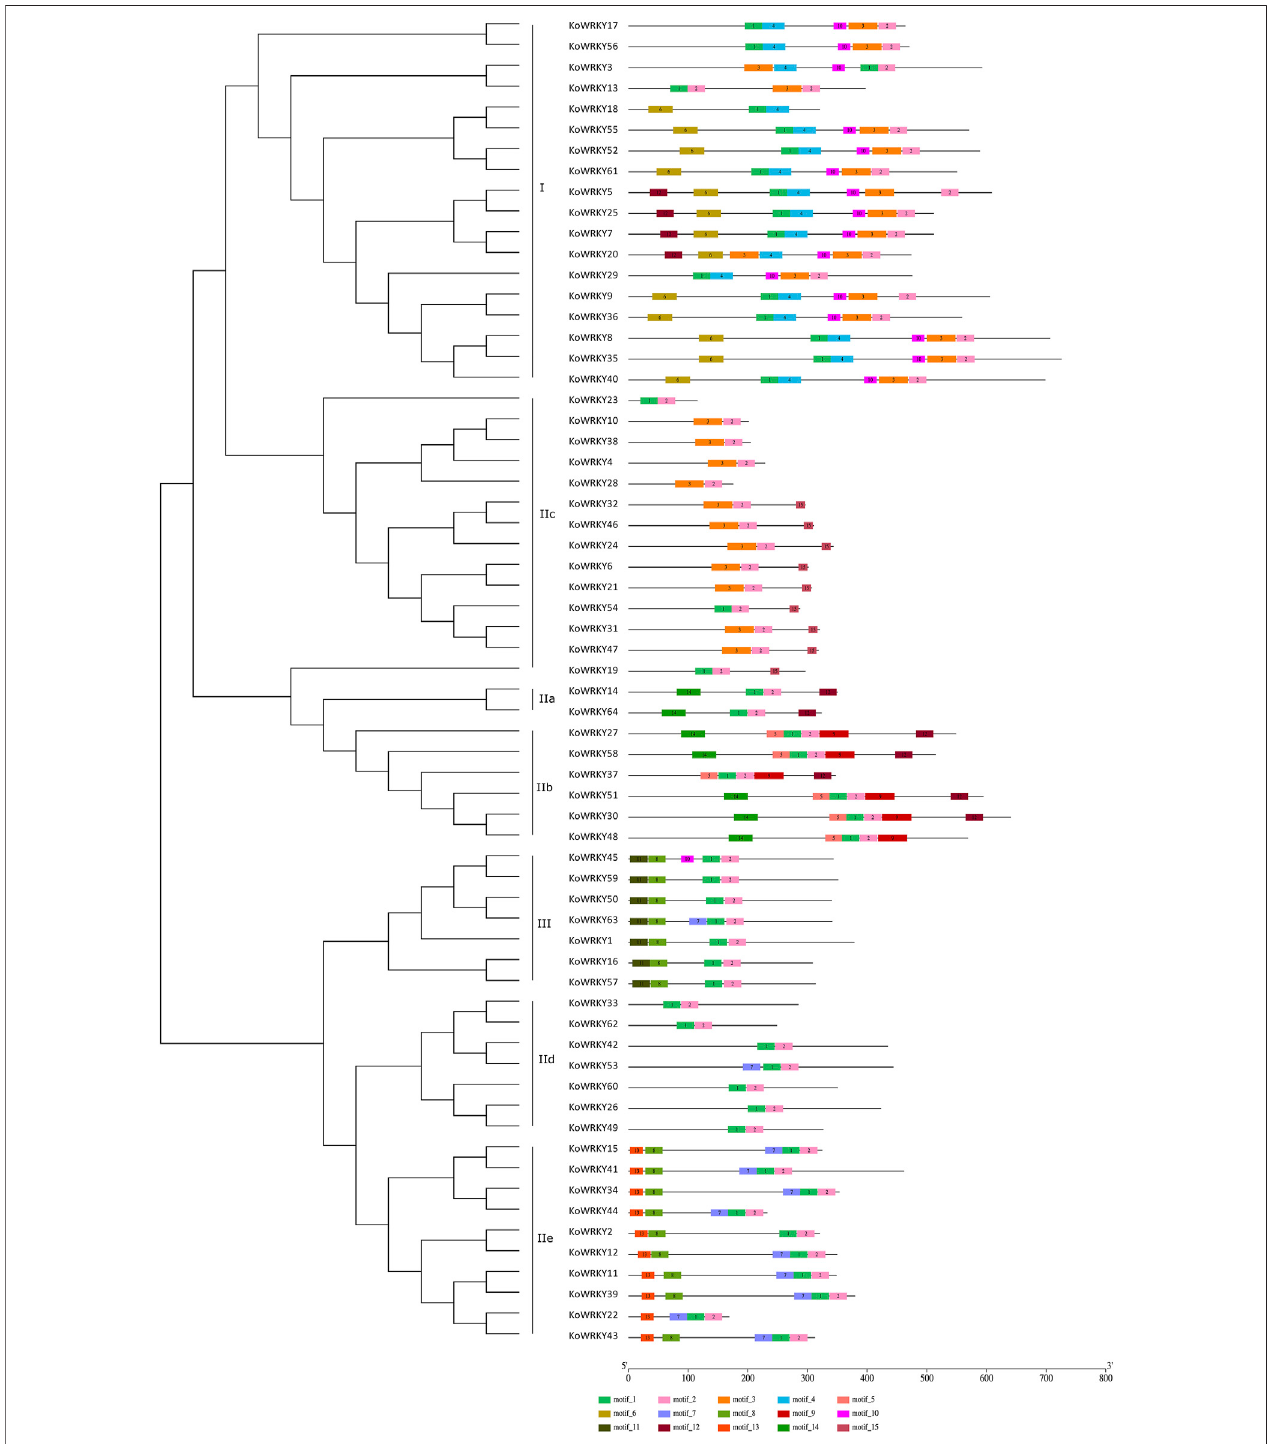
FIGURE 4 | Conserved motifs of the KoWRKYs arranged according to their phylogenetic relationships. The ML tree shown was constructed from the amino acid sequences of KoWRKYs via ClustalX and MEGA 5, with 1,000 bootstrap replicates. The conserved motifs in the KoWRKYs were identi fi ed using MEME. In total, 15 motifs were identi fi ed and are shown in different colors. The motif locations are also indicated.